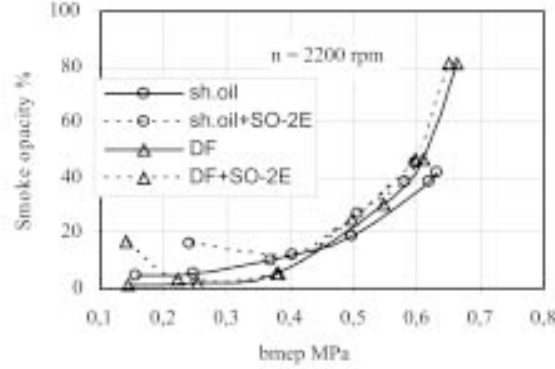
Fig 4 . Smoke opacity of Diesel exhausts as a function of load (bmep) at various revolution